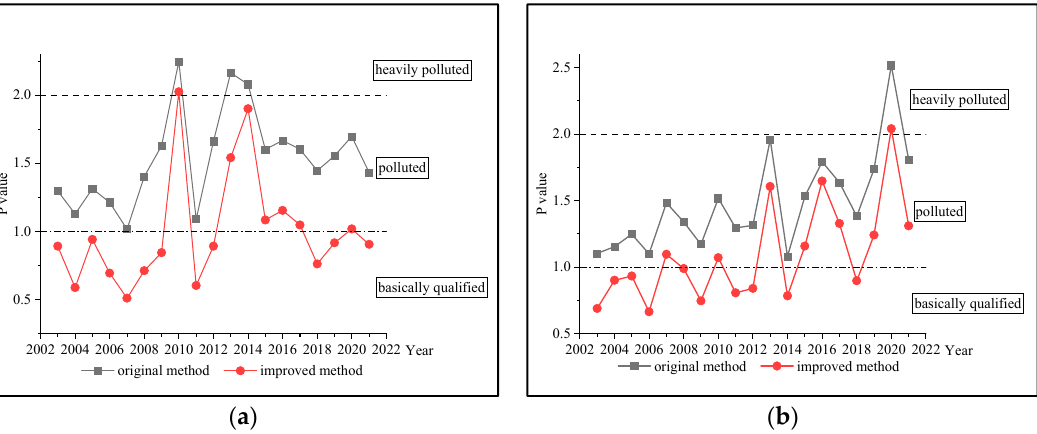
Figure 9. Comprehensive pollution index of the Gulou section from 2003 to 2021. ( a ) low water period (May), ( b ) high water period (September).